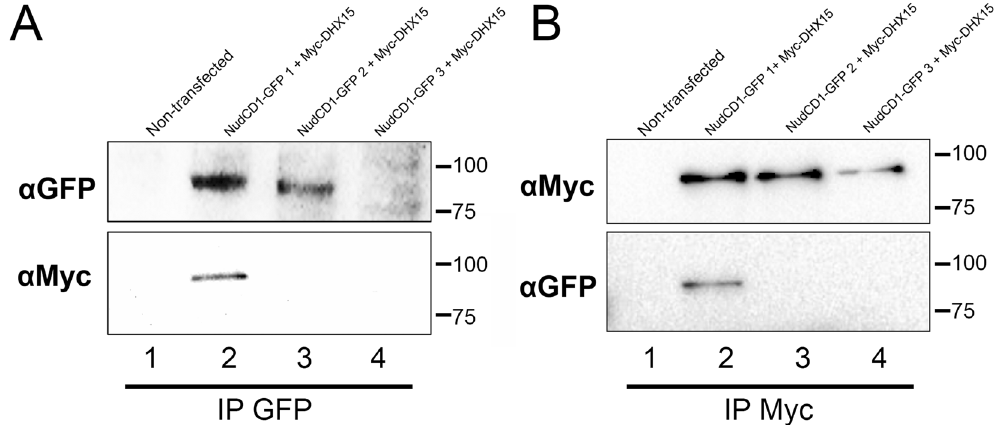
Figure 5. DHX15 interacts with NudCD1 isoform 1 only. To validate the interaction identified by mass spectrometry, co-immunoprecipitation experiments were realized in U2OS FT cell lines expressing NudCD1- GFP isoforms 1, 2 or 3 and co-transfected with a Myc-tagged DHX15. A GFP immunoprecipitation ( A ) and then the reciprocal immunoprecipitation with a Myc antibody ( B ) were performed and revealed with Myc and GFP